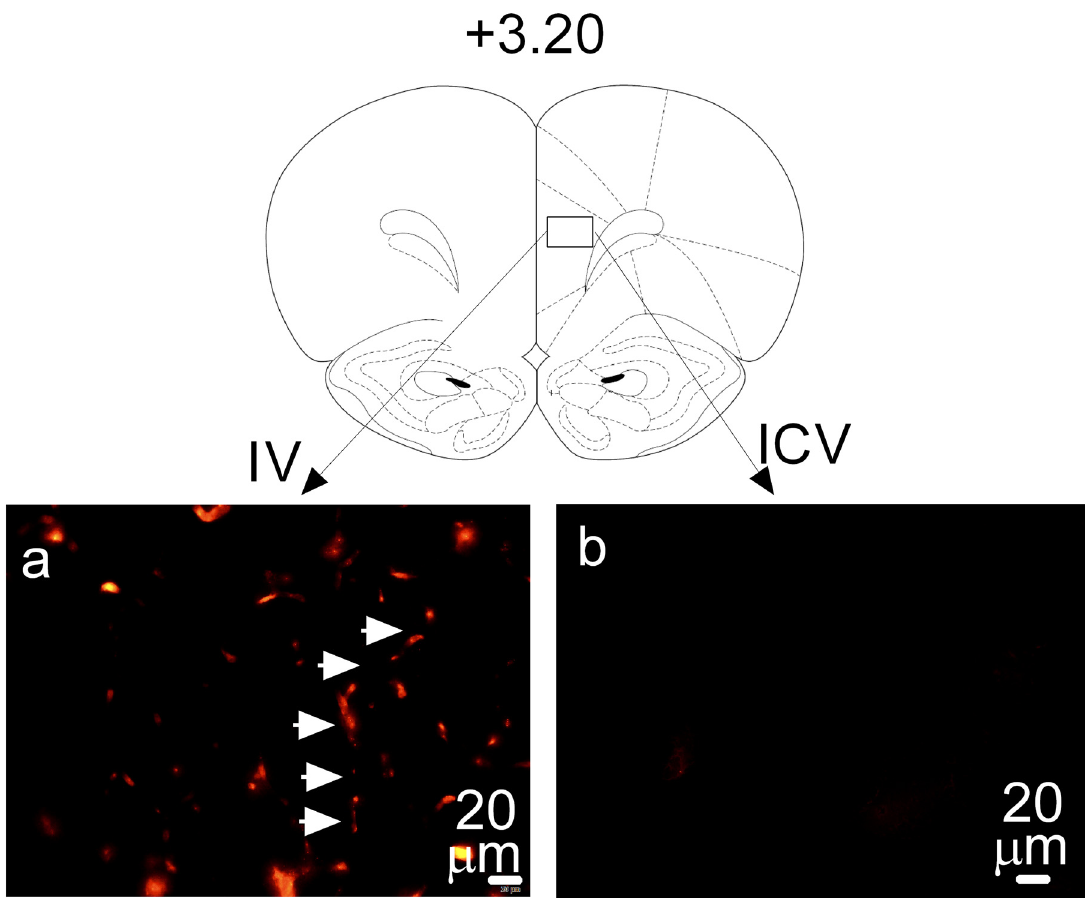
Fig 6. Relationship between routes of dye administration and distribution in the brain in male Sprague-Dawley rats. N = 4 rats/group. The dyes used in this test were DiI. FCx was used as a representative area for the brain. IV administration was used as a systemic administration, and ICV injection as an intracranial administration. Atlas coordinates in millimeters anterior to bregma, +3.20. Bars scale, 20 μ m. a, IV administration at 300 μ g/rat causes DiI distribution in the FCx capillaries (indicated by arrows). b, There is no DiI trace in the FCx following ICV administration of DiI (4 μ